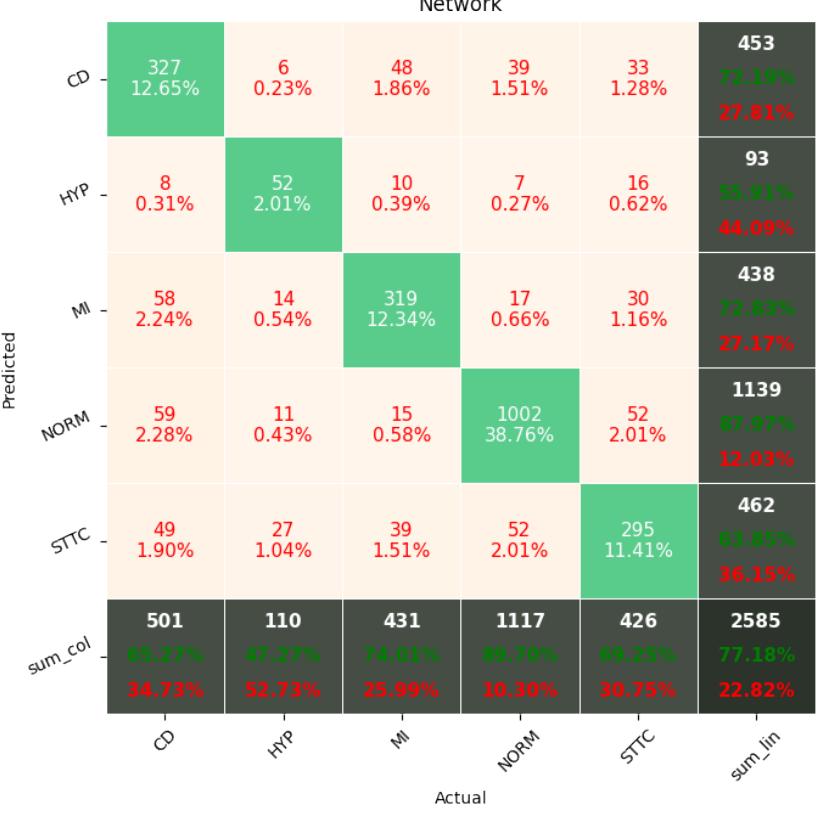
Figure 13. Confusion Matrix for softmax-based classification (5